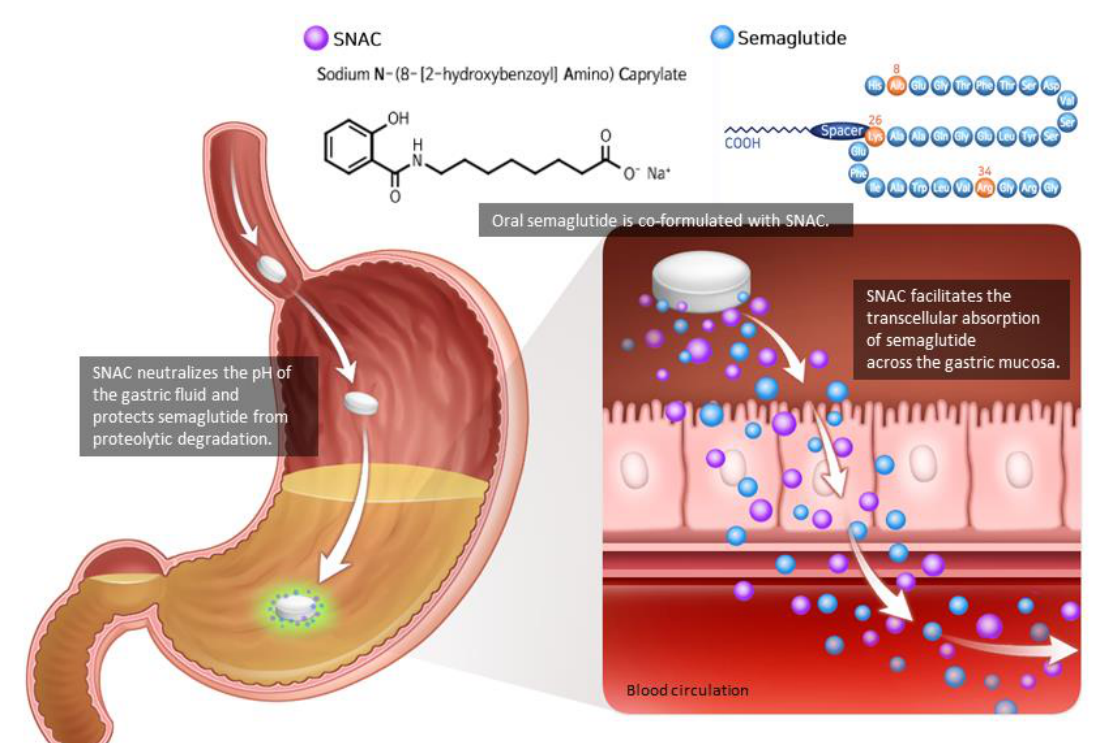
Figure 2. Oral semaglutide and SNAC. Oral semaglutide must be co-formulated with the absorption enhancer SNAC in order to be absorbed. SNAC raises the local pH, resulting in increased solubility and protection from proteolytic degradation. SNAC promotes the absorption of semaglutide across the gastric mucosa in a time- and concentration-dependent manner, which is totally reversible. Modified from Andersen et al. [33].